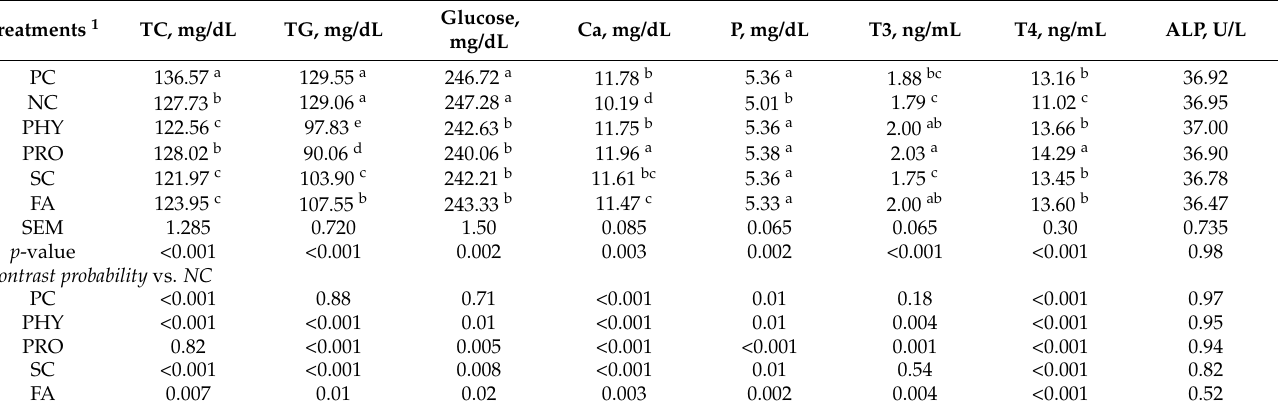
Table 6. Serum constituents and hormone profile of broiler chickens fed a reduced nPP diet supple- mented with phytase, probiotic, Saccharomyces cerevisiae, and fumaric acid at 21 days of